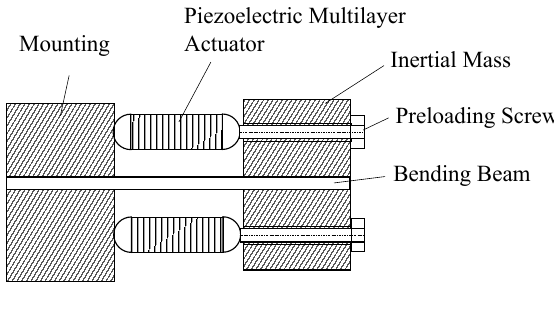
Figure 5. Basic design of the adaptive vibration